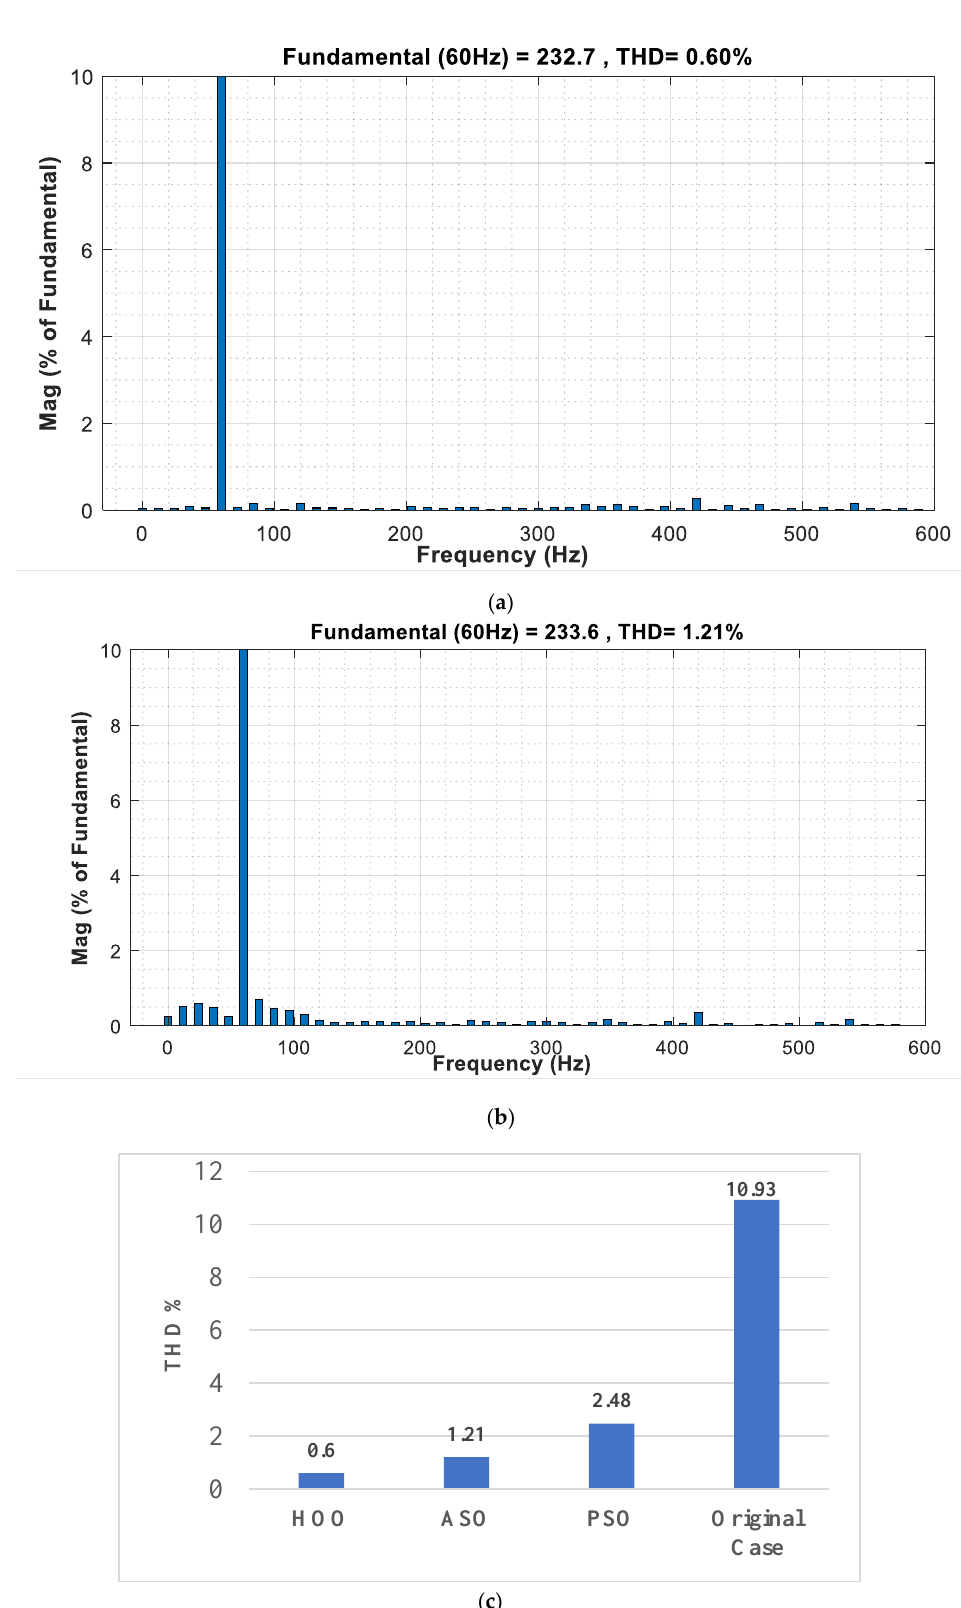
Figure 15. Total harmonic distortion (THD) analysis of the grid current in the original case.